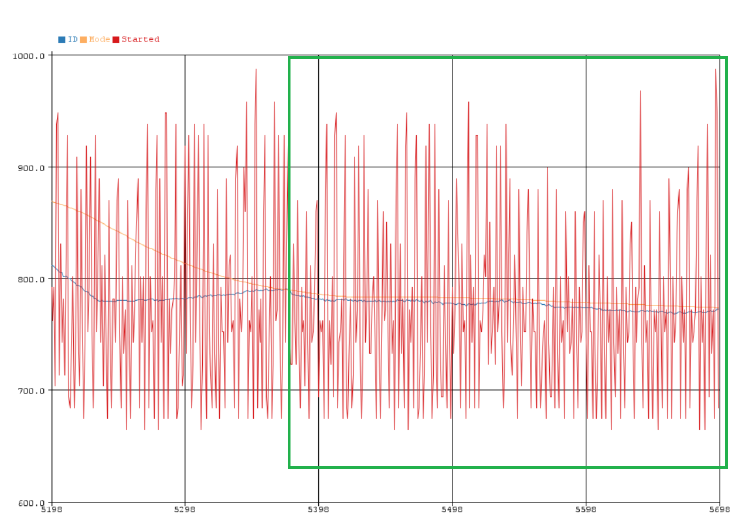
Figure 16. Intrusion Detection Mode after Detected 1.